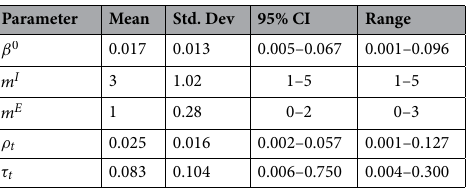
Table 2. Parameter estimates using data from 85 US universities other than